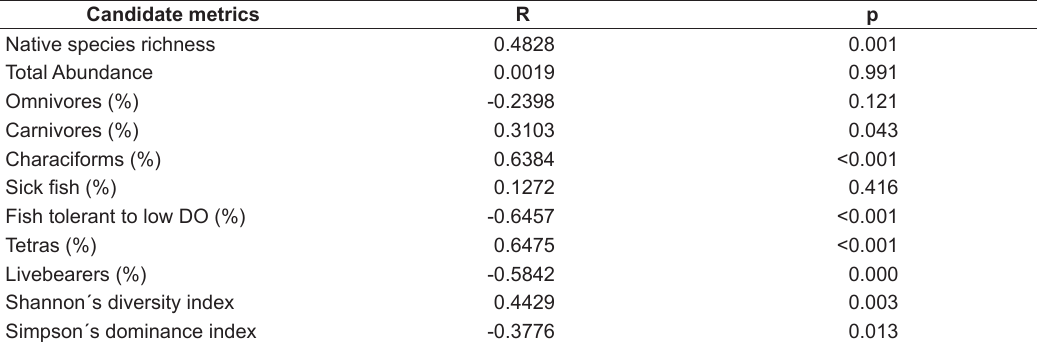
Table 2. Pearson correlation coefficients (R) and probabilities (p) for the relationships between each of the candidate metrics and the preliminary